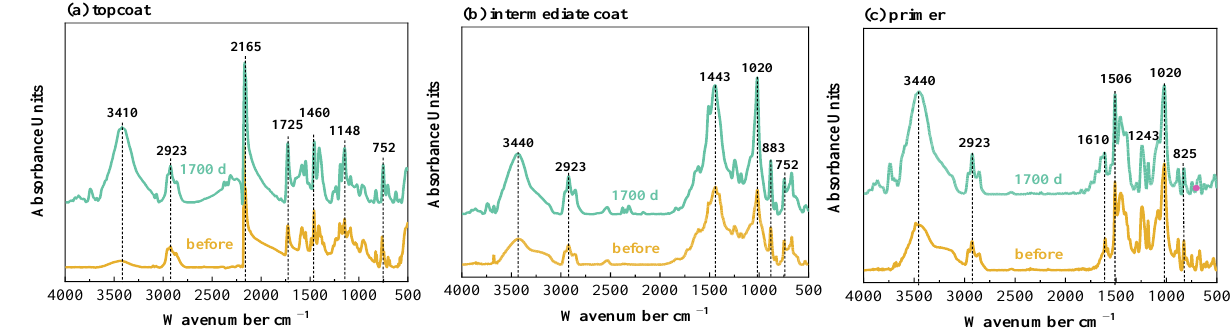
Coatings 2022 , 12 , x FOR PEER REVIEW